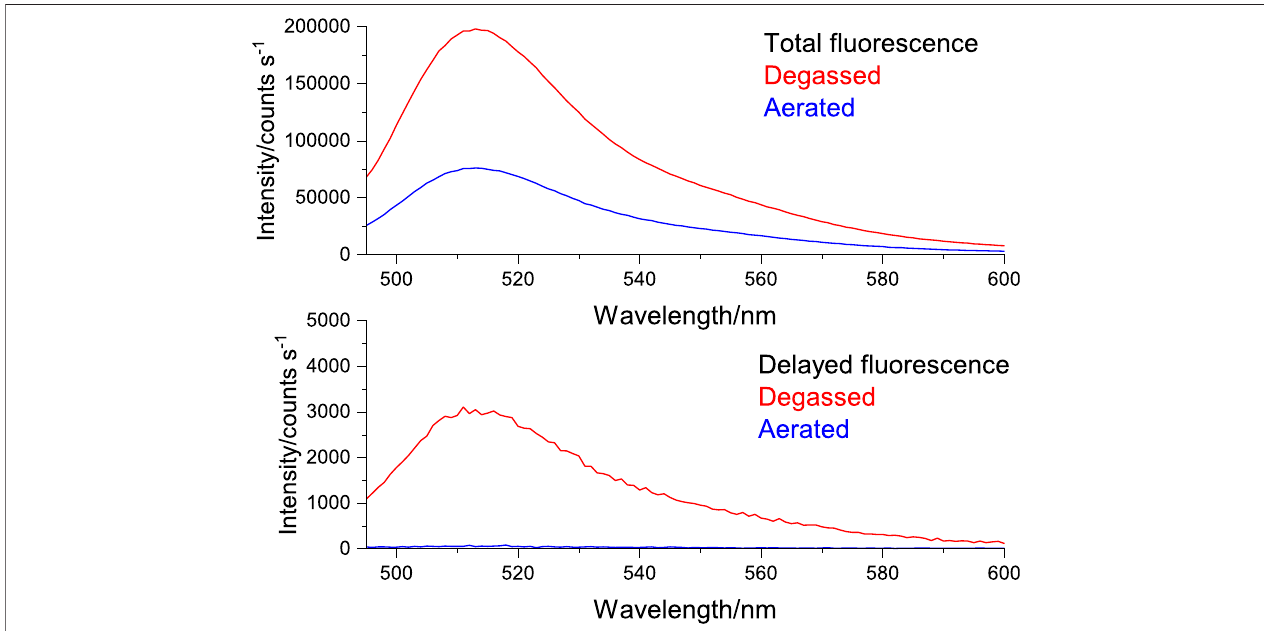
FIGURE2| Degassed(red)andaerated(blue),total fl uorescence(upperpanel)anddelayed fl uorescence(lowerpanel)fromliposomalDPTZ-DBTO2emittersfrom PD-10 separated fraction 1 ( Supplementary Figure S2 ), 5 mM DPTZ-DBTO2 emitter 100 nm liposomes. Excitation is 390 nm, emission 495 – 595 nm. Delayed emission (lower panel) collected 10 μ s after excitation. See text for